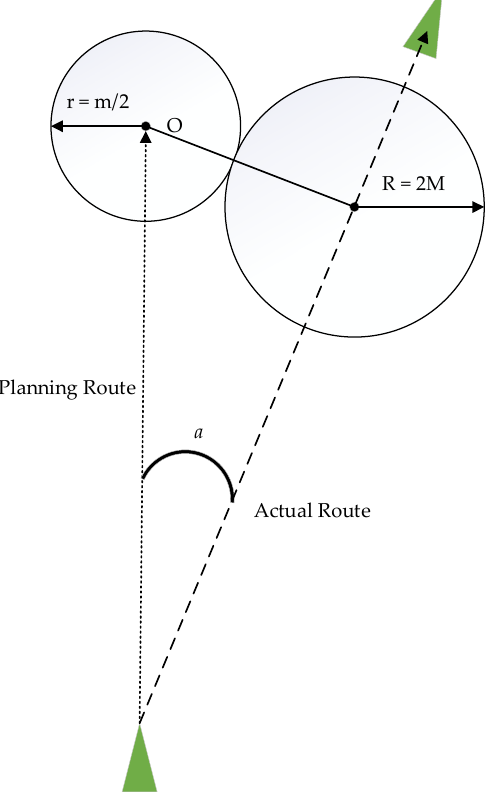
Figure 3. Ship navigation risk determination.